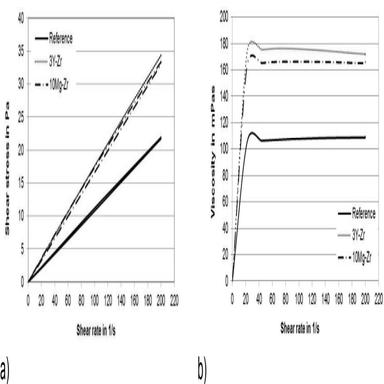
Flow and viscosity curves of the stock solutions used for electrospinning.